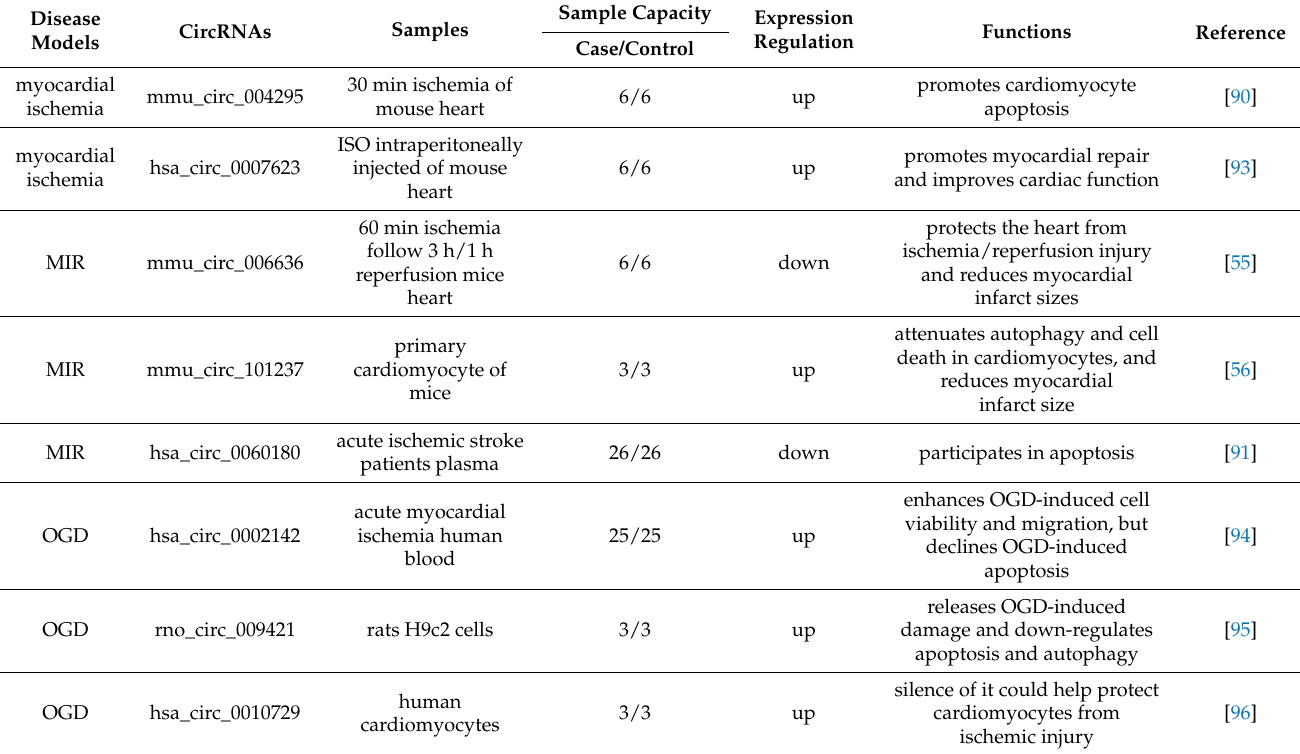
Table 4. CircRNAs as potential biomarkers in myocardial ischemia models validated by real-time RT-qPCR. Disease